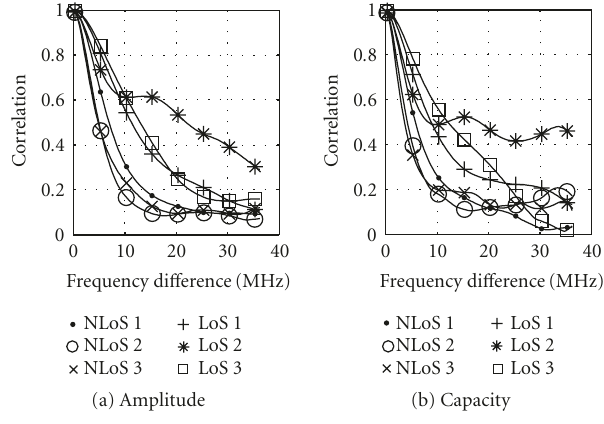
Figure 7: Theoretical 4 (SNR = 15dB).